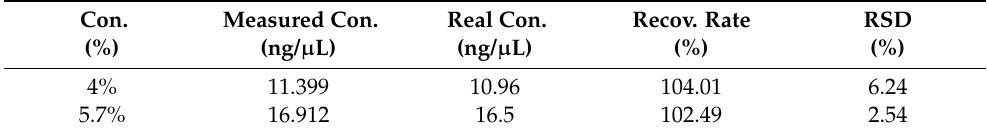
Table 1. Real sample detection (N = 3).